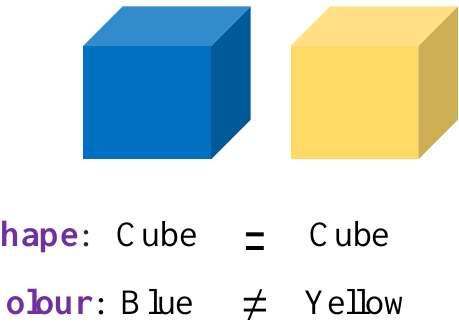
Figure 1. Comparison of boxes with the same shape and different